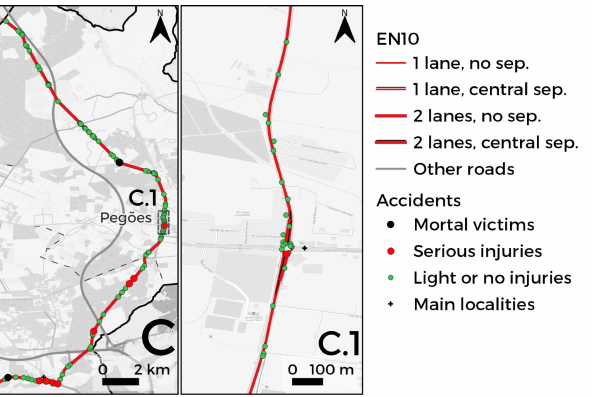
Figure 4. Section C and its main area ( C.1 ); RTA between 2016 and 2019 according to their